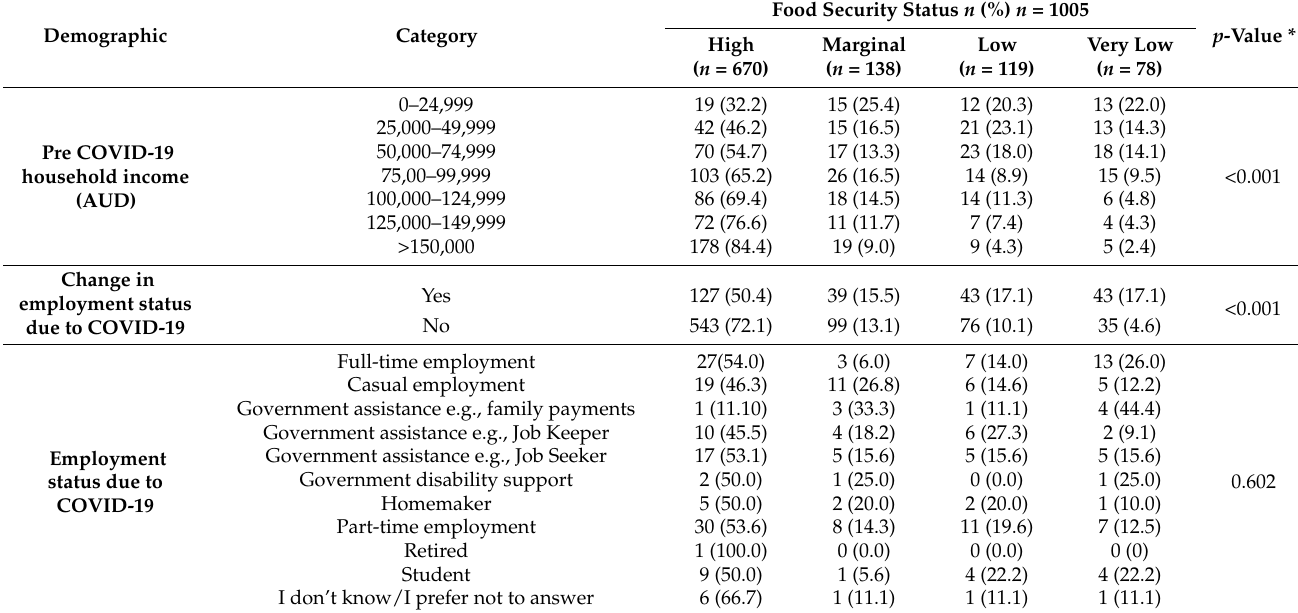
Table 1 footnotes: * p -value calculated via